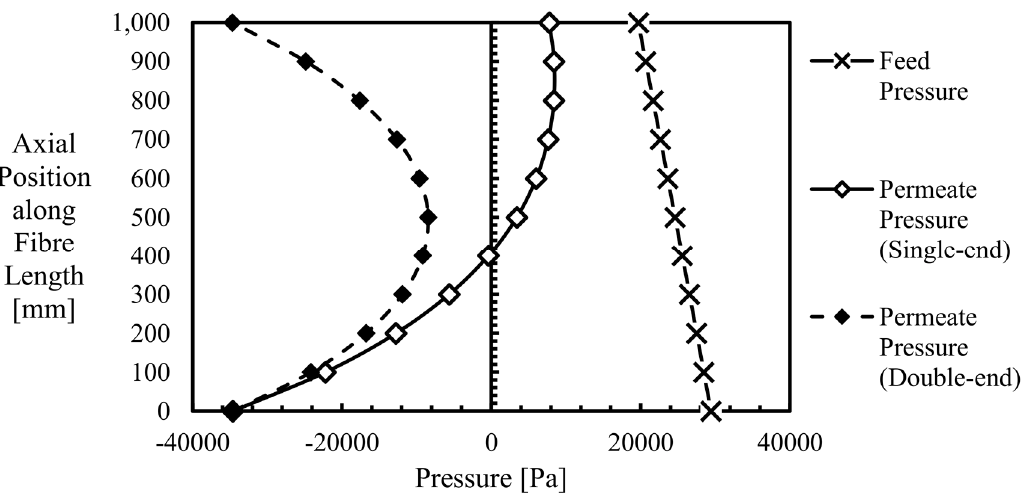
Figure 16. Feed and permeate pressure distribution of fibre with 0.4 mm inner diameter, 0.3 membrane thickness, and membrane permeability of 5.56 × 10 − 16 m 2 (550 LMH/bar), in single-end and double-end suction. λ value of this fibre was calculated to be 3.04 m − 1 .